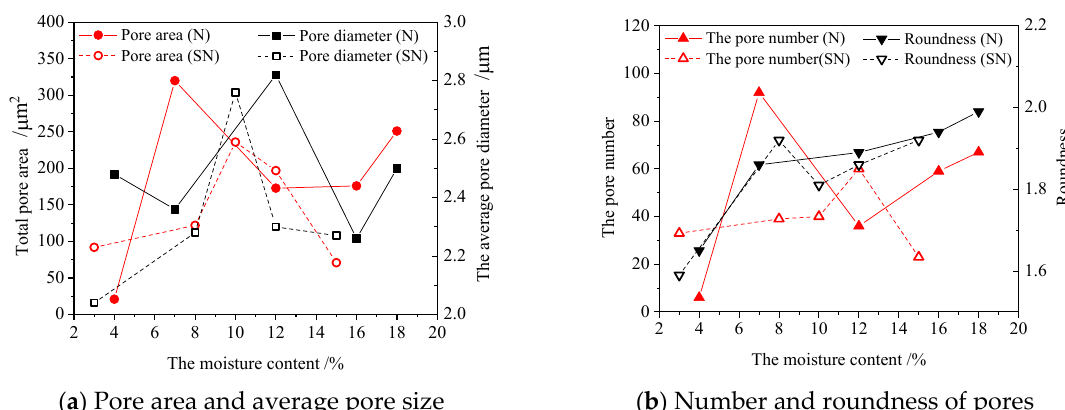
Figure 8. Main pore characteristic parameters of mudstone.